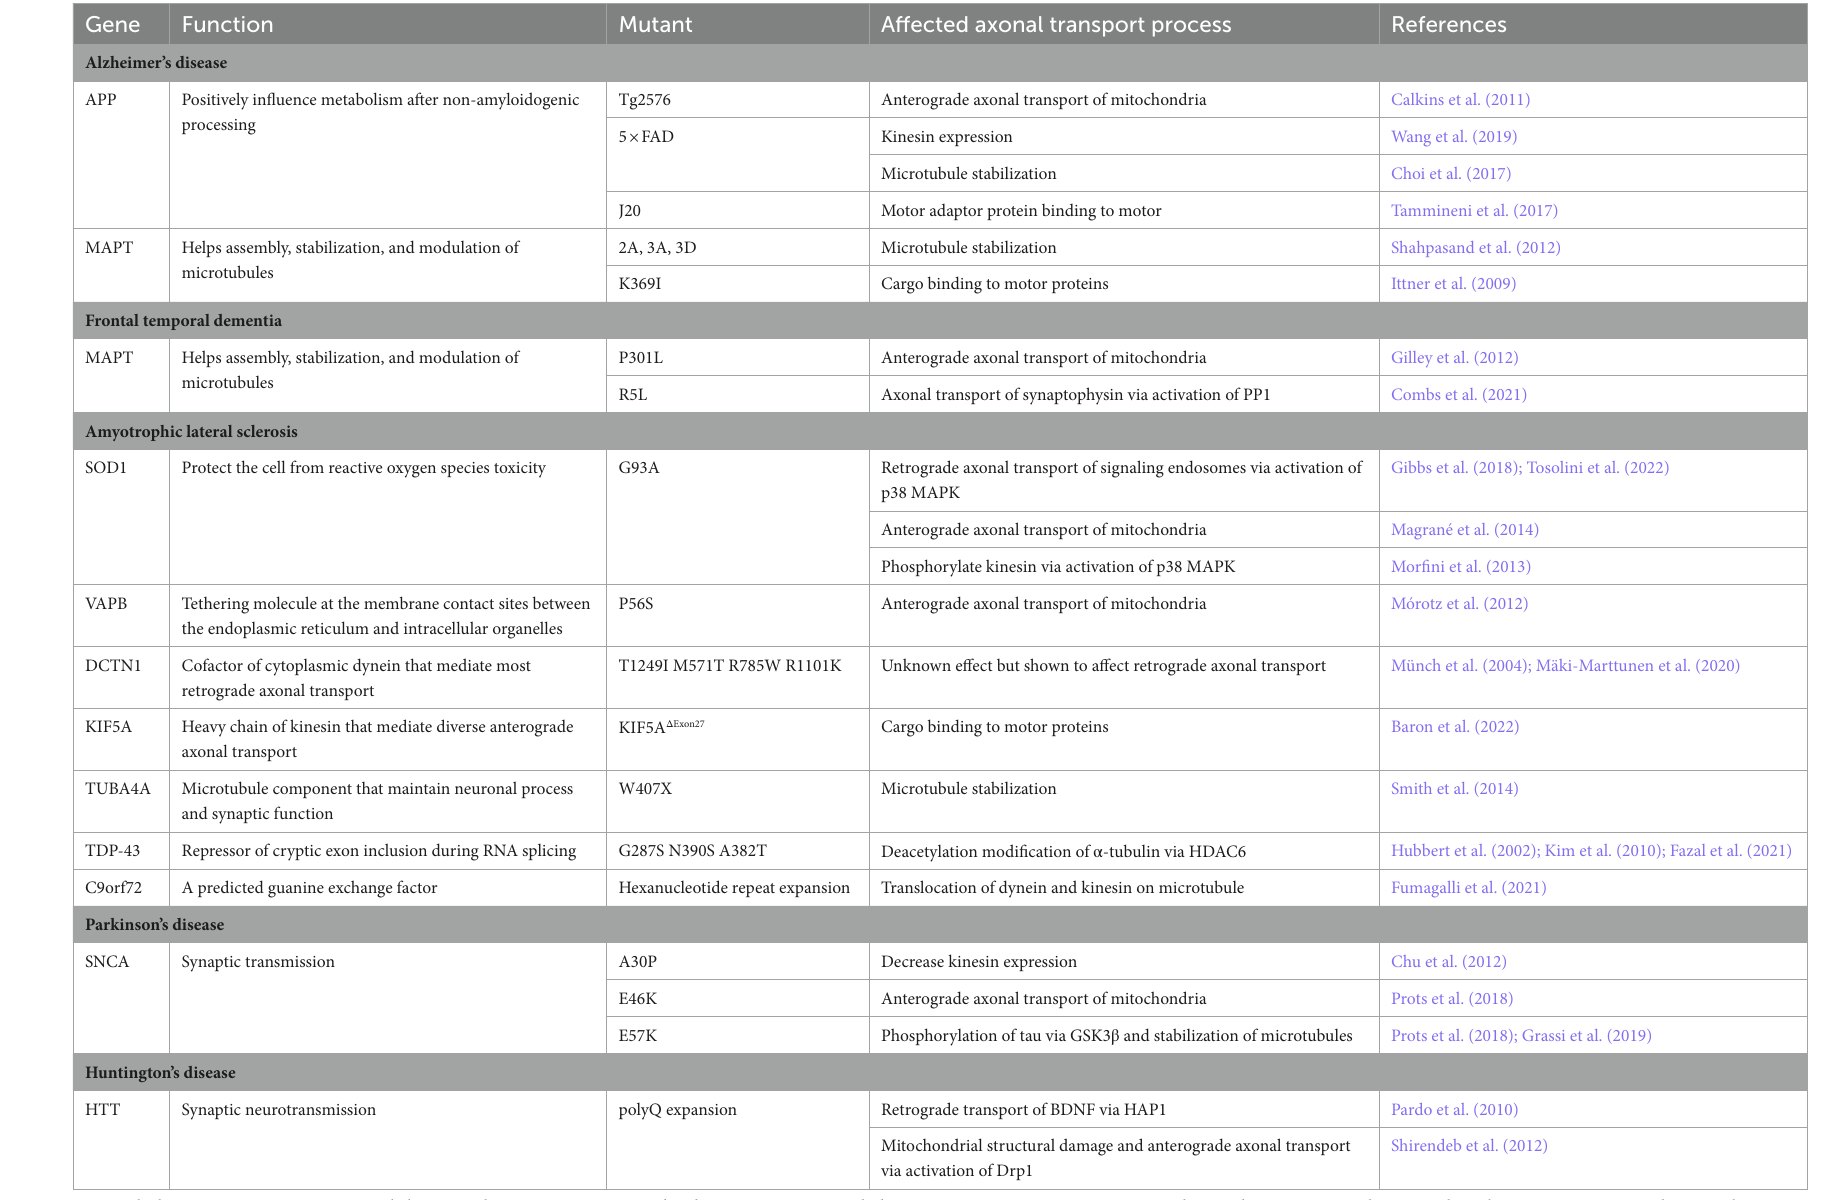
APP: amyloid precursor protein; MAPT: microtubule associated protein tau; PP1: protein phosphatase 1; SOD1: superoxide dismutase 1; p38 MAPK: p38 mitogen-activated protein kinase; VAPB: vesicle-associated membrane protein B; DCTN1: dynactin subunit 1; KIF5A: kinesin family member 5A; TDP-43: TAR DNA binding protein 43; HDAC6: histone deacetylase 6; SNCA: α -synuclein; GSK3 β : glycogen synthase kinase 3 β ; HTT: huntingtin; BDNF: brain-derived neurotrophic factor; HAP1: huntingtin-associated protein 1; Drp1: dynamin-related protein